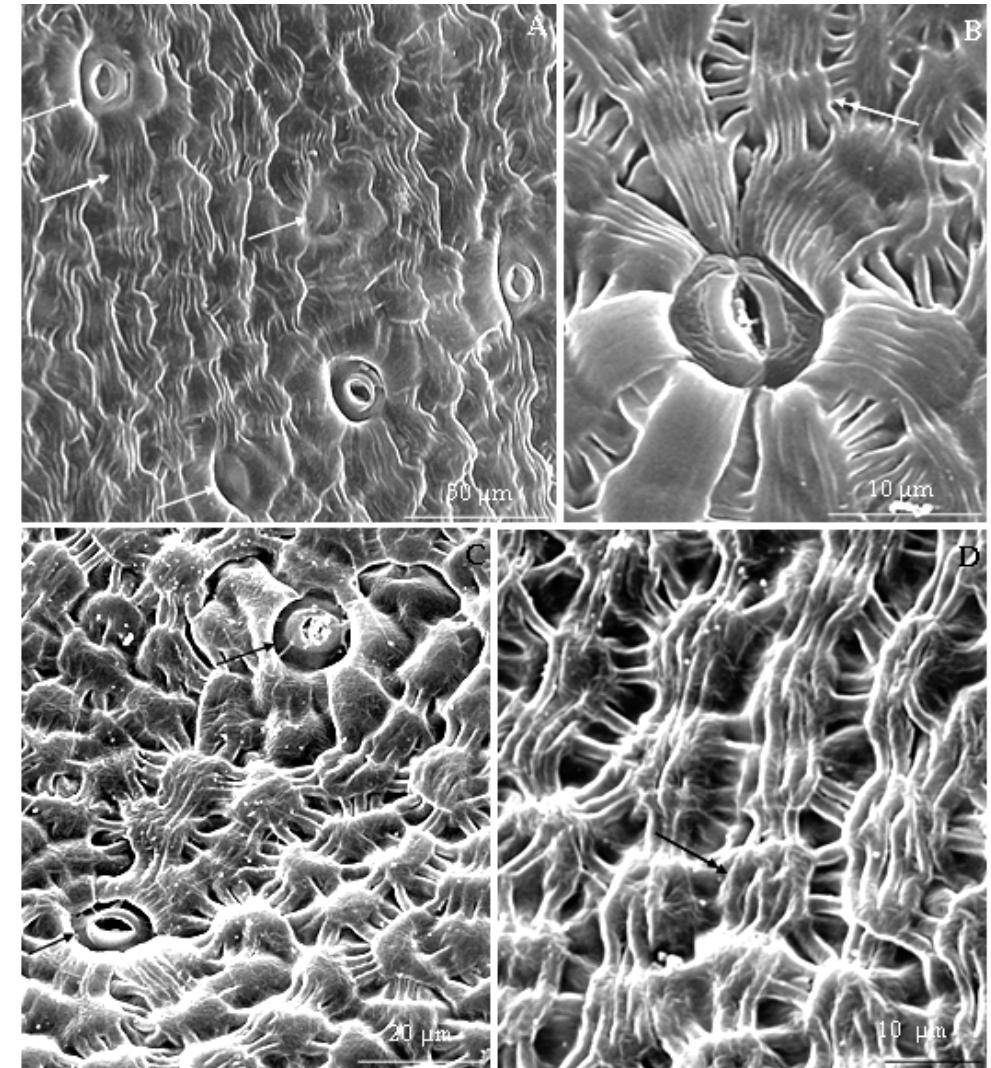
Figure 6. ( A – D ). Fragments of the nectary epidermis surface in the initial secretion phase in R. idaeus ‘Glen Ample’ ( A , B ) and ‘Laszka’ ( C , D ). ( A ): distinct cuticular stripes arranged in bands (double-headed arrow), stomata (arrow) in various stages of development. ( B ): open stoma located at the level of other epidermis cells. ( C ): open stomata (arrow), bands along the longer cell axis with a distinct indentation in contact with the adjacent cell; striae between the bands arranged perpendicularly or slightly obliquely relative to the bands. ( D ): striated cuticle ornamentation, visible unidirectional longitudinal bands formed by striae (double-headed arrow).